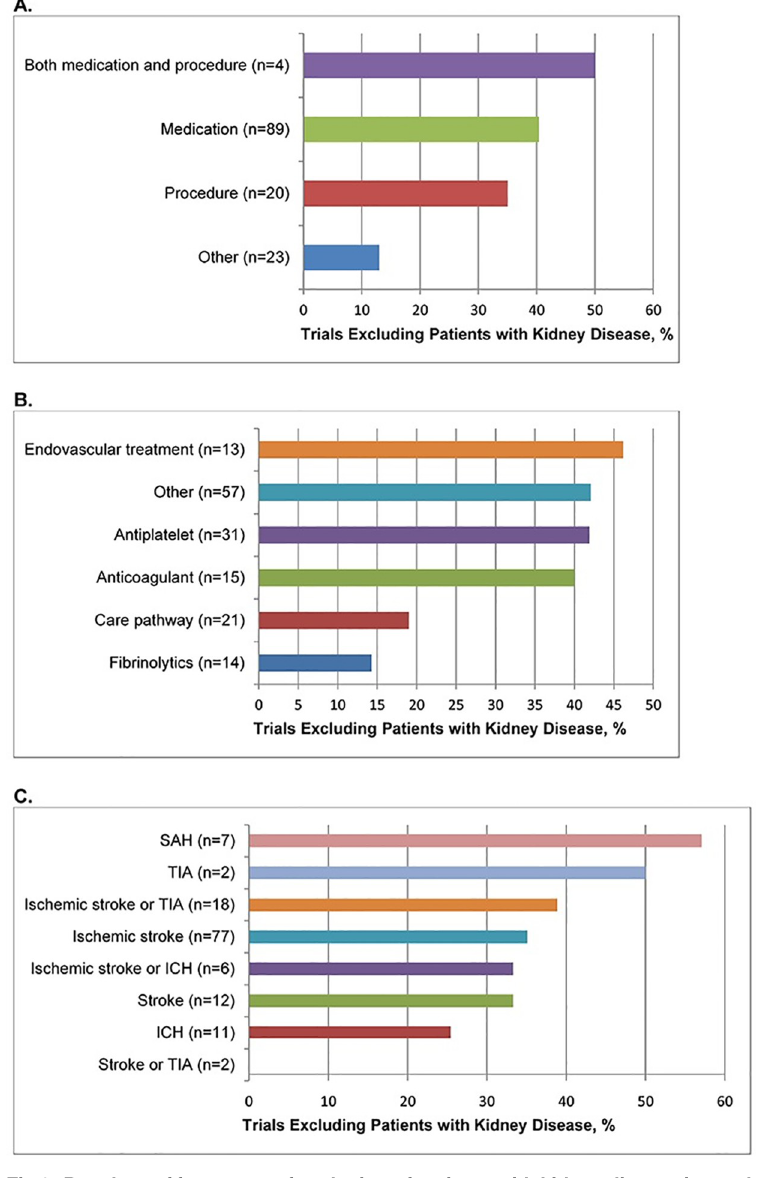
Fig 2. Bar chart of frequency of exclusion of patients with kidney disease in cerebrovascular trials by (A) Broad categories of treatment (B) Specific categories of treatment (C) Specific categories of diagnosis. Abbreviations: SAH (subarachnoid hemorrhage), TIA (transient ischemic attack), ICH (intracerebral hemorrhage). participants. Only 7 (15.9%) of trials excluded KD patients. Patients with KD were less likely to be excluded from European compared to North American trials and more likely to be excluded from moderately large trials. Frequency of exclusion did not differ by any other trial characteristic. Of the trials that excluded KD patients, serum creatinine and renal replacement therapy were each used in 2 trials, eGFR and creatinine clearance were each used in one trial, and nonspecific qualitative exclusion criteria were used in 4 trials. Baseline renal function was reported in a single trial, whereas 2 (4.5%) trials reported the proportion of patients with renal